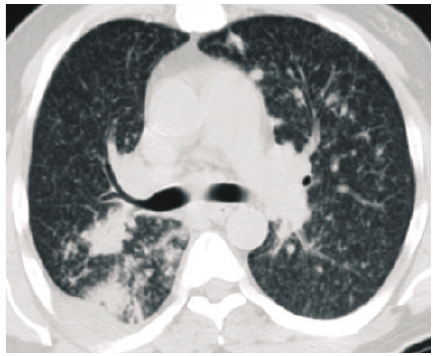
Figure 4: CT scan obtained 2 weeks following the initial evaluation confirmed the miliary dissemination, progression of the index mass lesion, and several new satellite